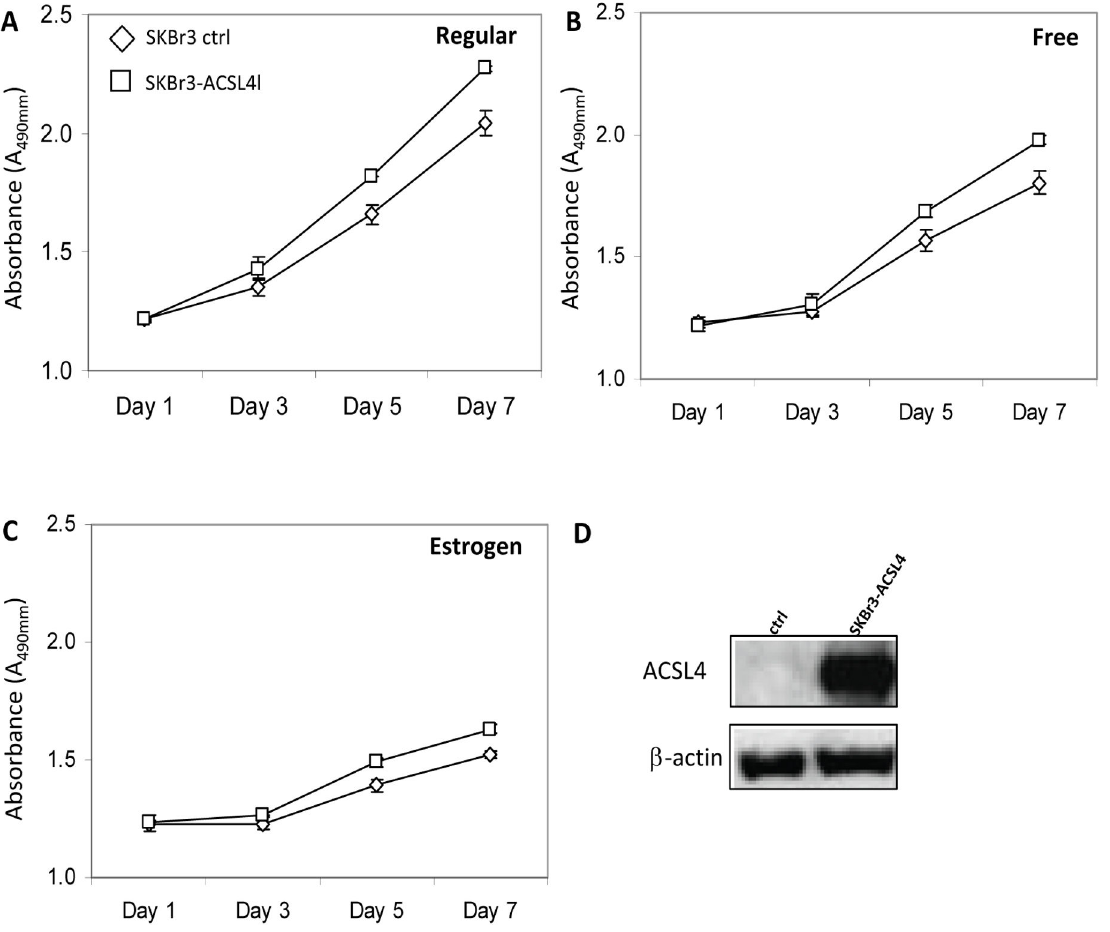
Figure 7. Effect of ACSL4 on growth of SKBr3 cells. Control- and ACSL4-tranfected SKBr3 cells were cultured in complete medium ( A ), or phenol red-free, charcoal-stripped medium without ( B ) or with ( C ) added estrogen. Values shown are the means of triplicate determinations ± 1SD. The differences between the curves are significant: A , p<0.0001; B , p<0.0001; C , p<0.0001. Panel D , immunoblot analysis of whole cell lysates for expression of ACSL4 in control and ACSL4-transfected